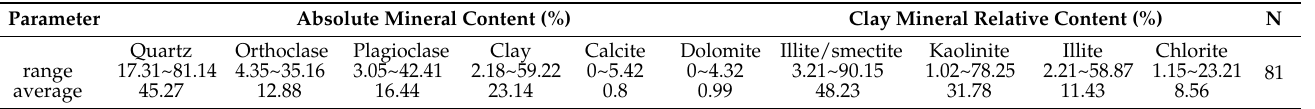
Table 2. Mineral composition of the Guantao